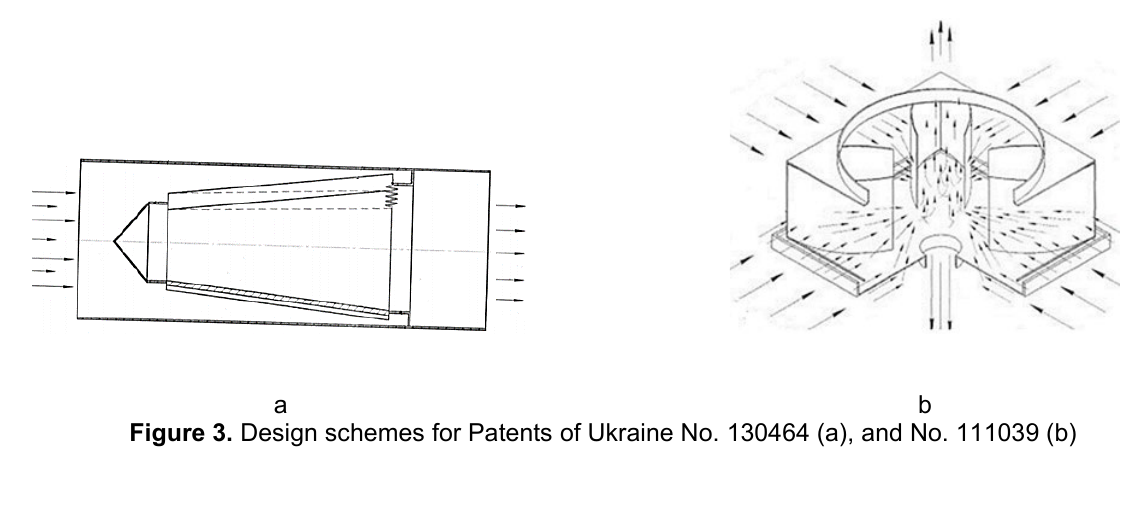
Figure 2. Characteristics of modular separation devices (MSD)